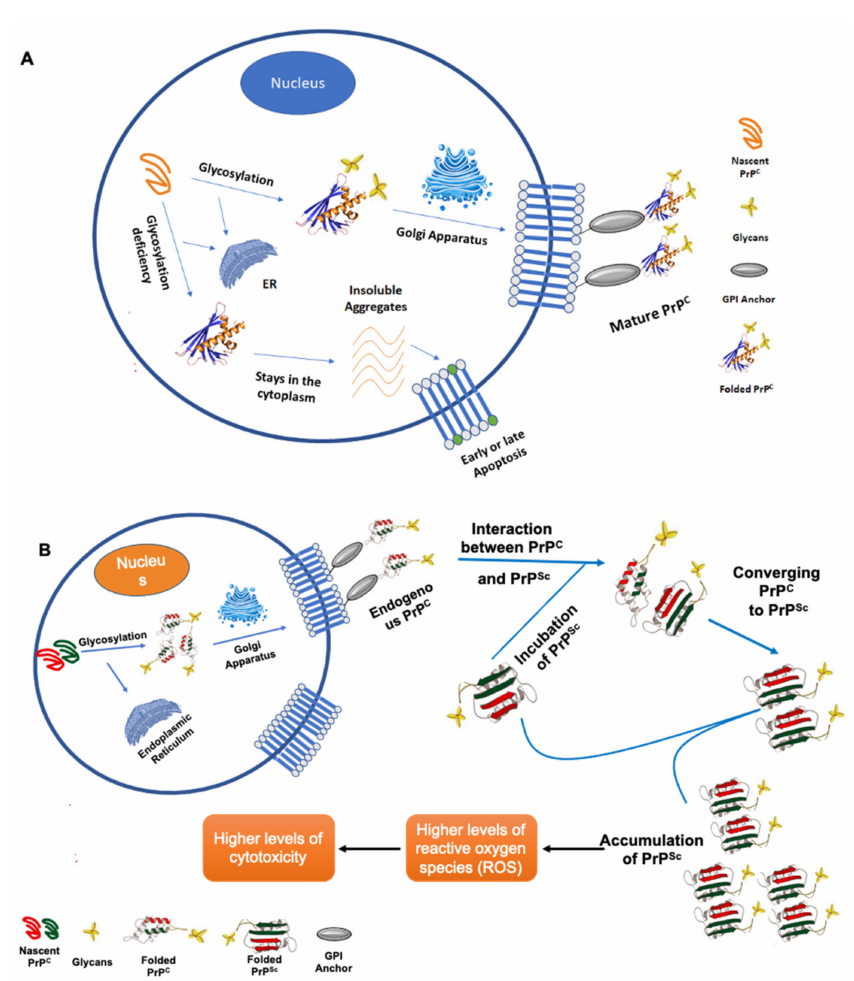
Figure 4. The process of glycosylation of normal PrP and the effect of deficiency in glycosylation or conversion of PrP C to PrP Sc . ( A ) In normal conditions, nascent PrP undergo glycosylation which occurs in the Endoplasmic Reticulum (ER), then it matures in the Golgi apparatus and eventually reaches the plasma with the aid of GPI anchor. However, when glycosylation deficiency occurs, the nascent PrP becomes insoluble aggregates which leads to early or late apoptosis (green label). ( B ) Mature PrP C at the level of the plasma may interact with PrP Sc , and this would lead to a conversion and accumulation of PrP Sc which in turn would increase the level of cytotoxicity due to the presence of this prions